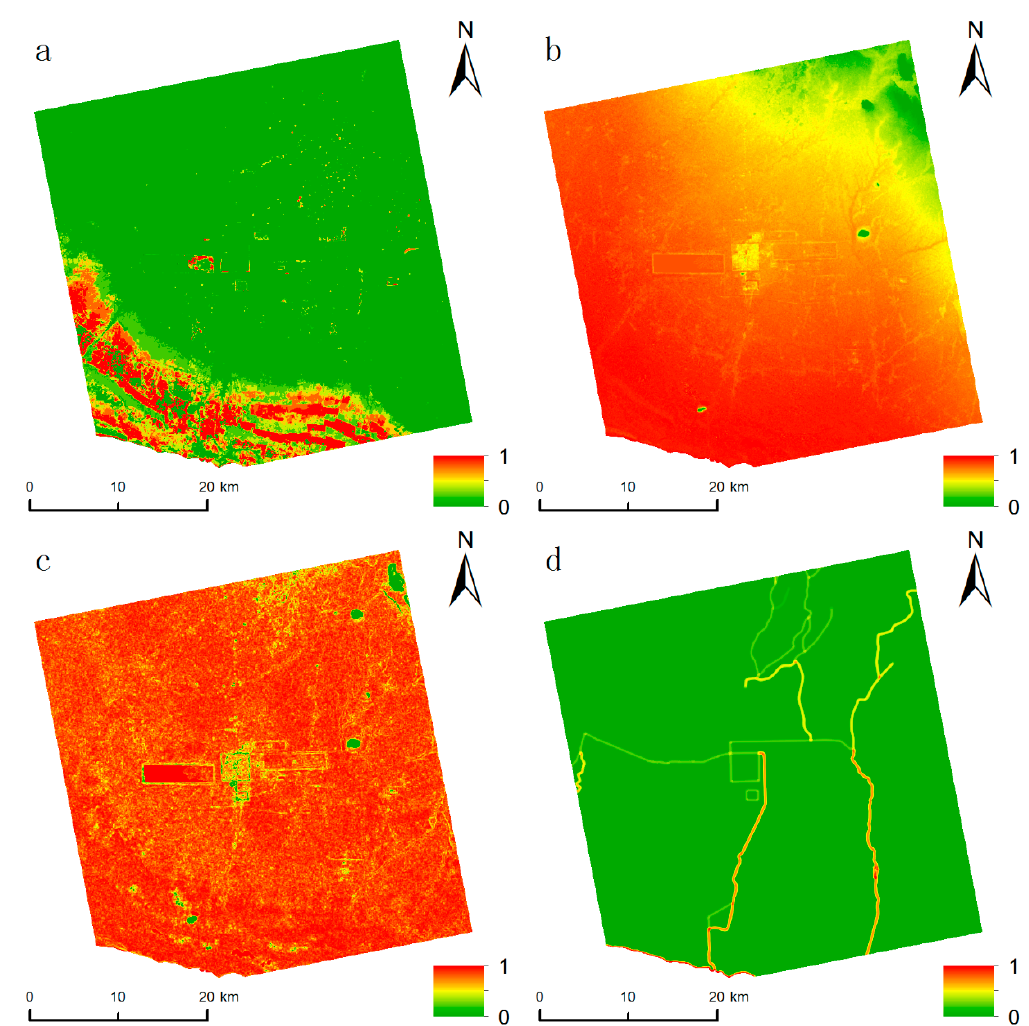
Figure 6. The normalized risk index map, ( a ) flood affected frequency, ( b ) absolute elevation, ( c ) elevation standard deviation, ( d ) drainage density. The greater the value, the higher the possibility of being inundated by a flood.